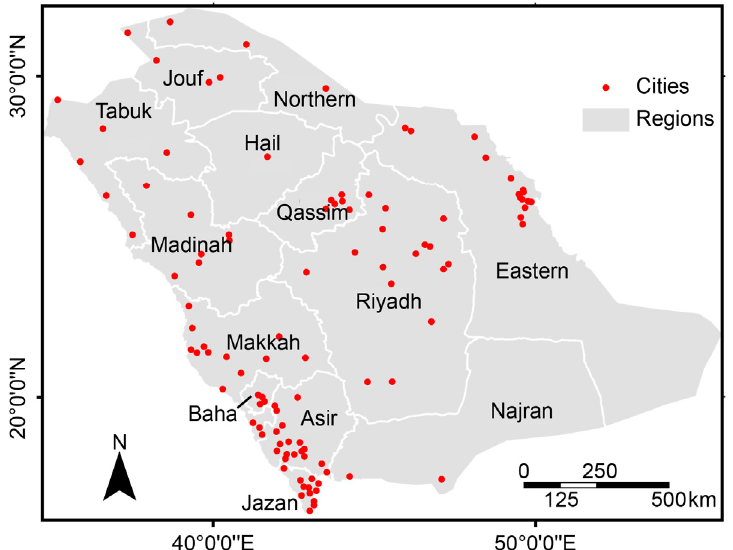
Figure 5. Regions and cities of Saudi